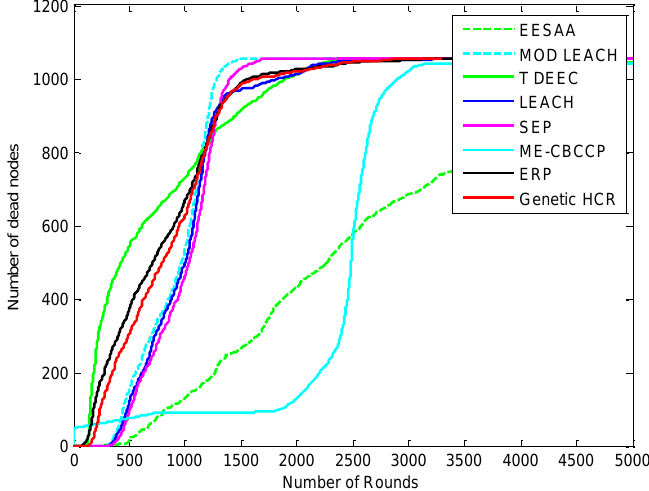
Figure 3. Network lifetime comparison (1000 nodes, with the help of alive nodes, 200 m 2